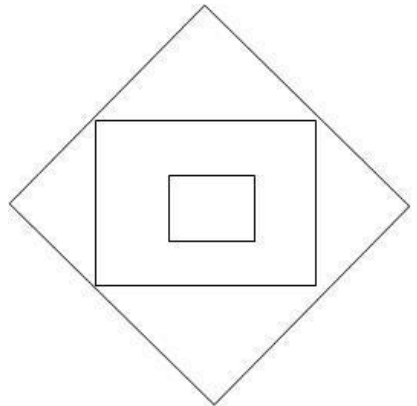
Figura 2. Alvo para treino de precisão dos passes Os passes de saque de vôlei por baixo são frequentemente utilizados pelos atletas com pontuação baixa (0.5, 1.0 e 1.5) e consistem em